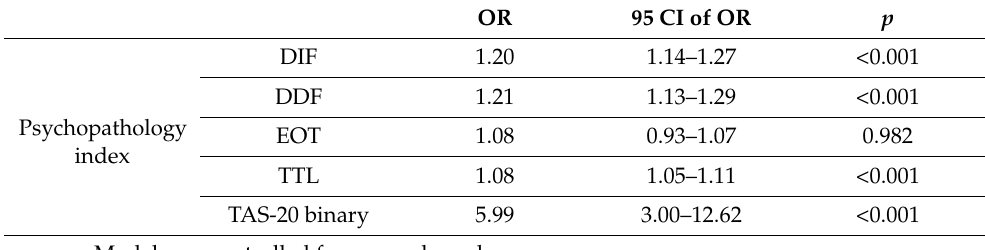
Table 3. Binomial regression analyses for the prediction of the psychopathology index by each scale of